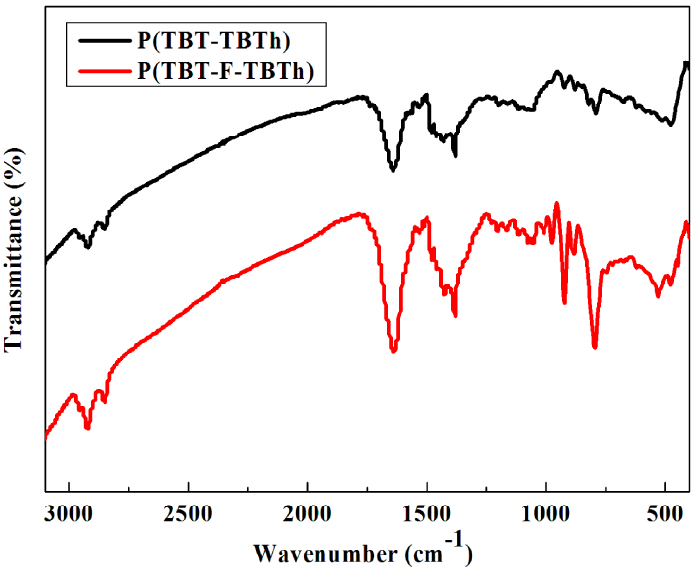
Figure 1. The FT-IR spectra of P(TBT-TBTh) and P(TBT-F-TBTh).